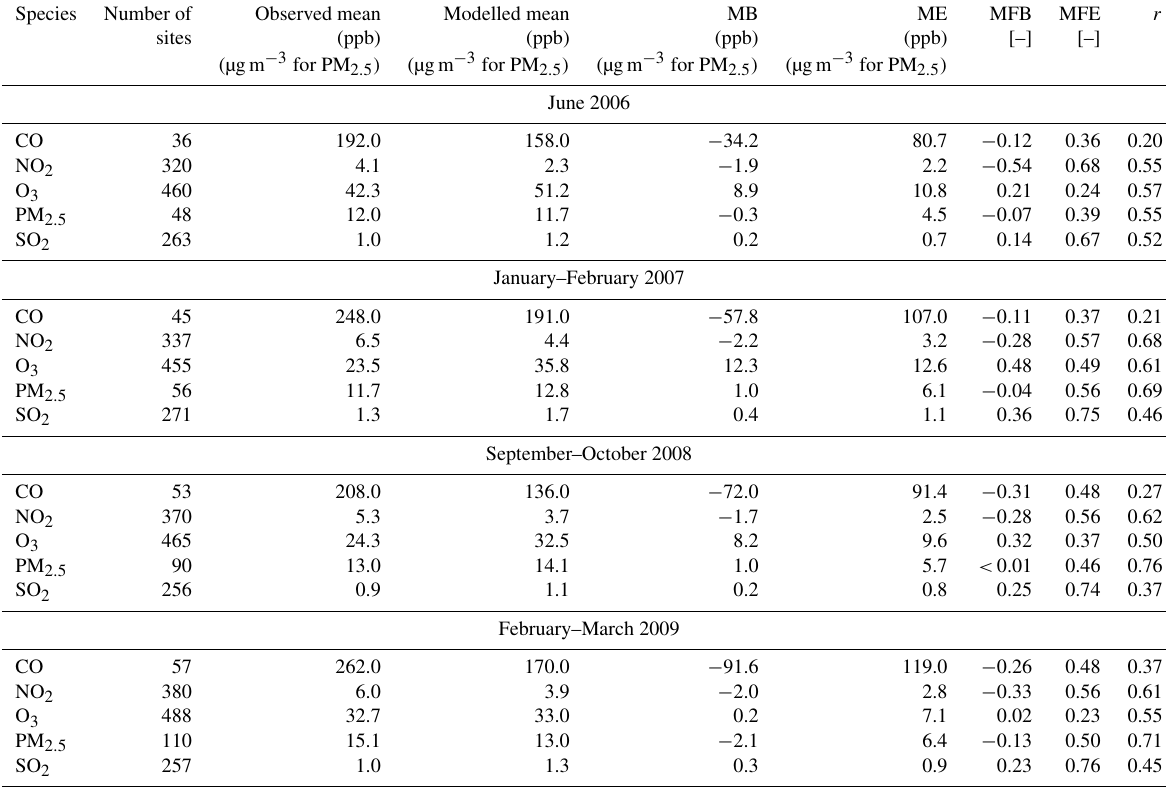
Table 2. Model gas phase and PM 2 . 5 performance for the EDIII field campaigns (base case VBS_BC).